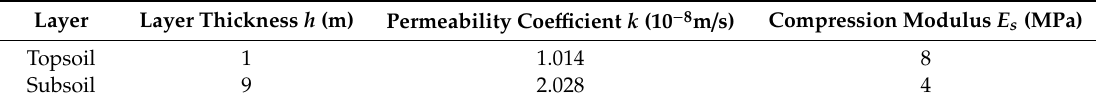
Table 2. Study data of perfectly permeable boundary conditions.